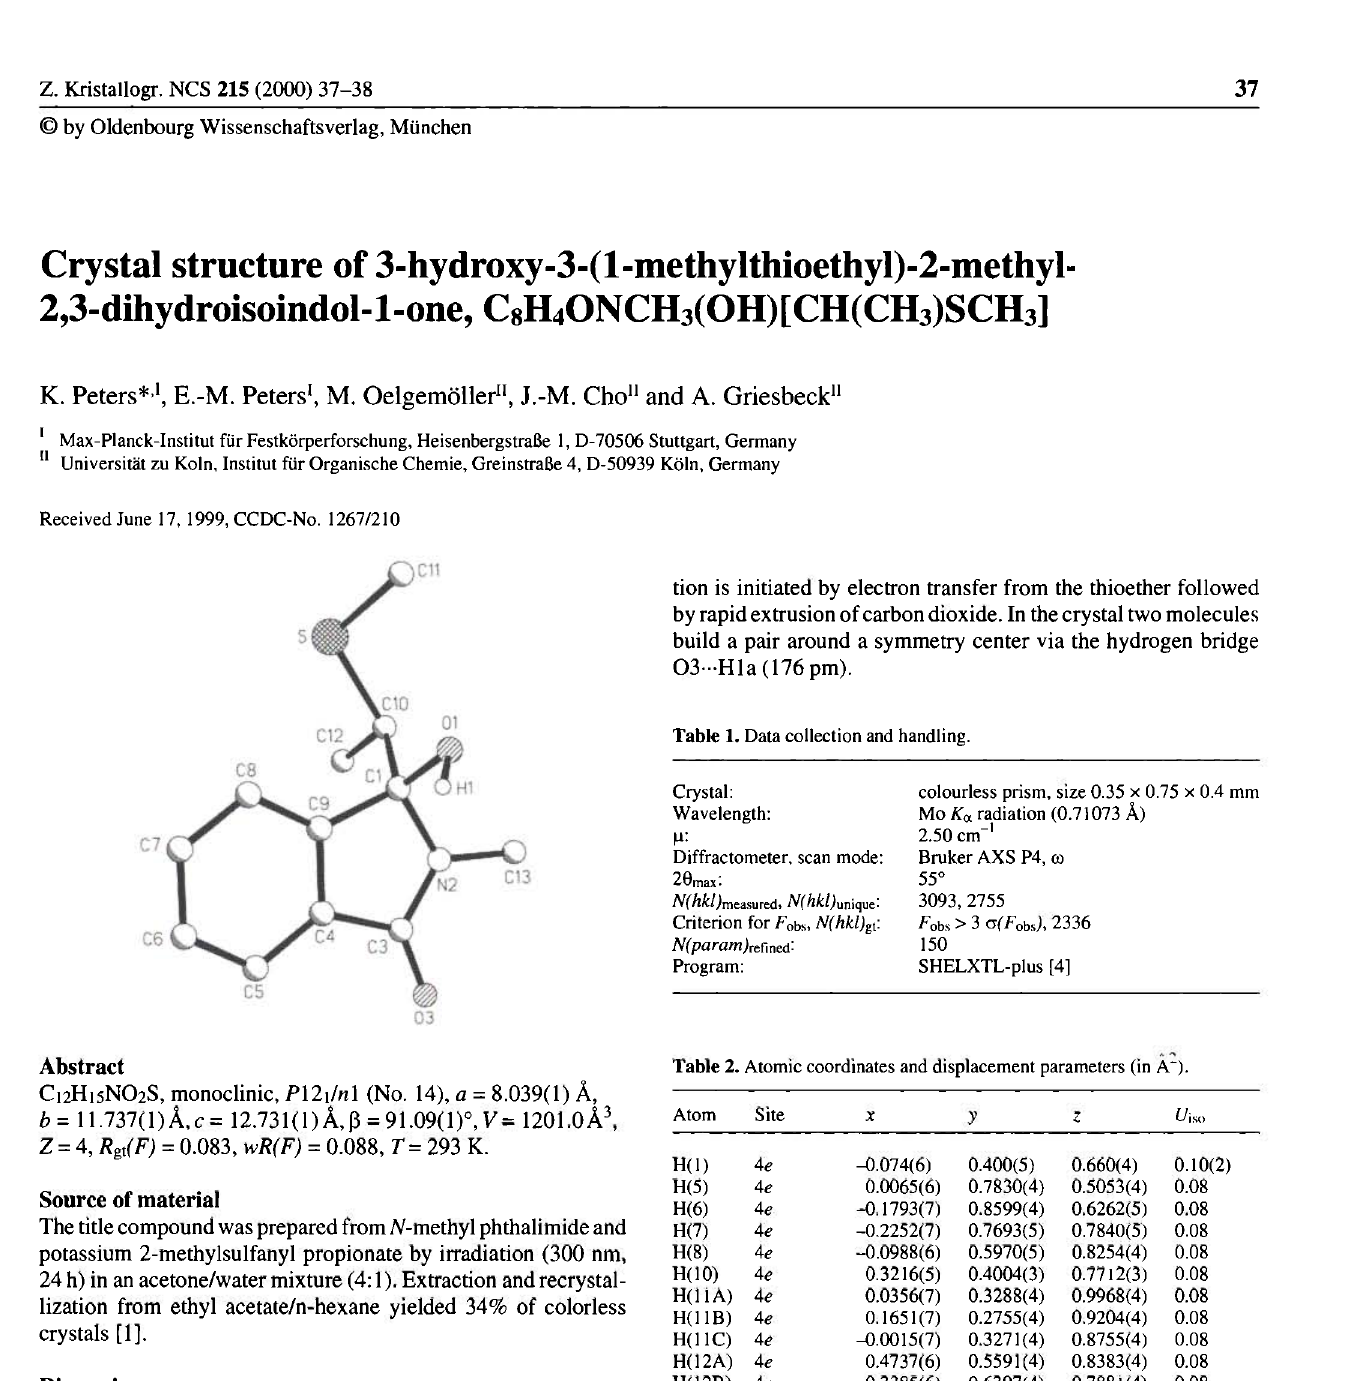
Table 2. Atomic coordinates and displacement parameters (in A").